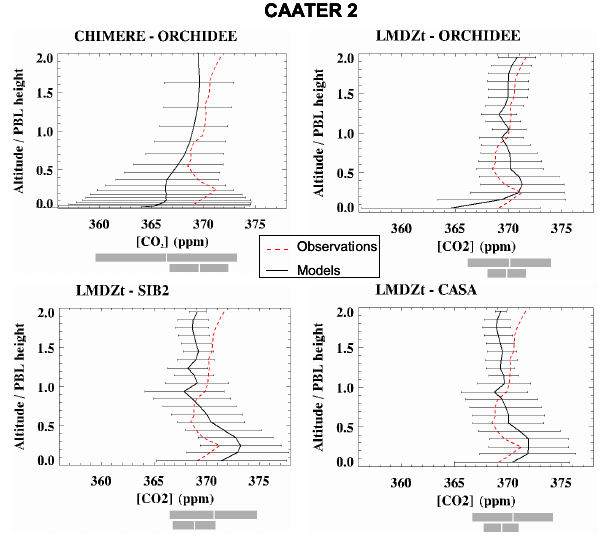
Fig. 4. Comparison of the mean modeled and observed profiles for CAATER 2. Horizontal bars represent the ± 1- σ standard deviation of the mean, computed every 1/10th of the altitude/ABL height ra- tio. Below the x-axis, the global mean and the ± 1- σ variability in the ABL (upper bar) and FT (lower bar) are shown according to the CO 2 concentration scale given by the